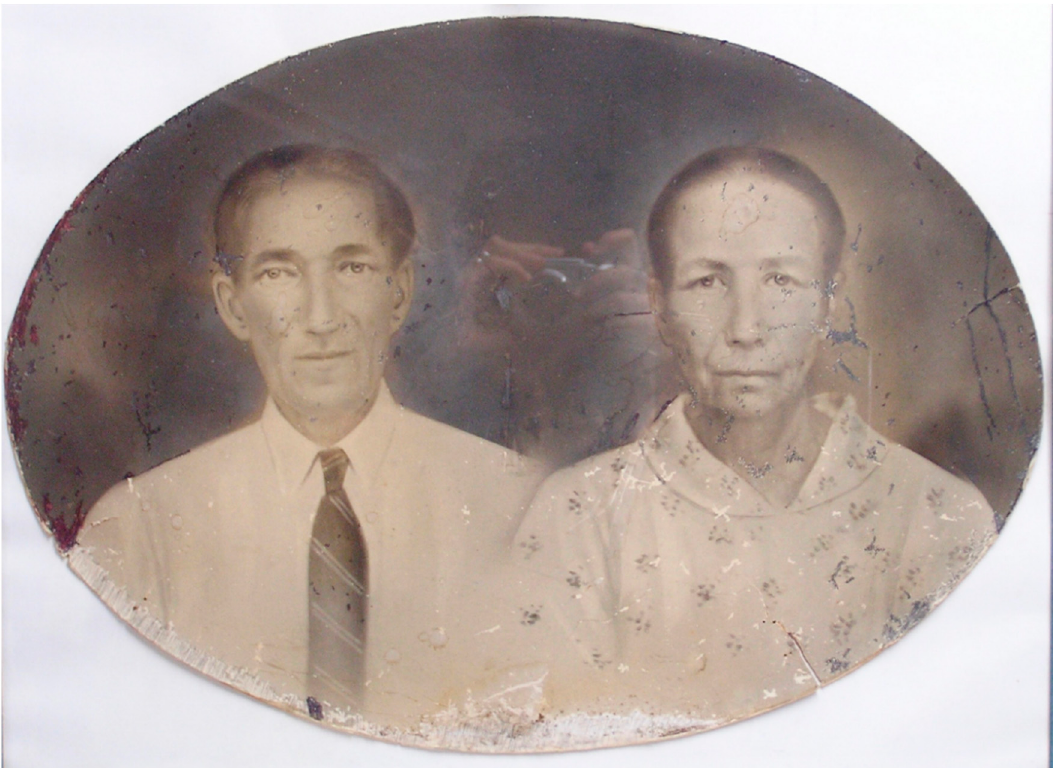
Figure 8. Bartolo Arocho Matias & Herminia Gonzalez Hernandez of Pueblo, Moca, P.R. Bartolo was the brother of Mauricio Arocho Matias, husband of Juana Rodriguez Lassalle. ca. 1940s. Courtesy of Lic. Lorenzo Caban Arocho and family; photo taken by author, 2007.